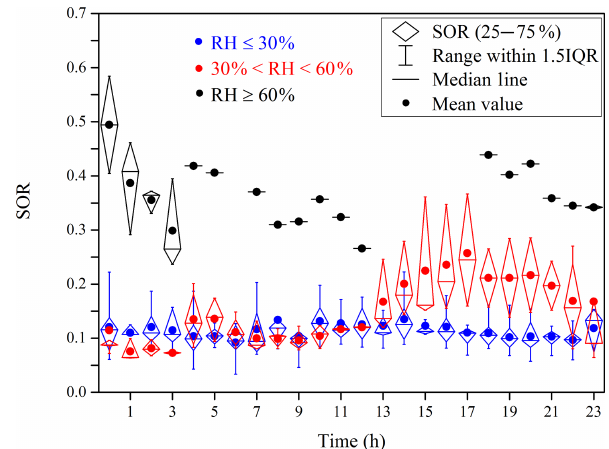
Figure 4. Daily variation in SOR under different atmospheric RH conditions during the sampling